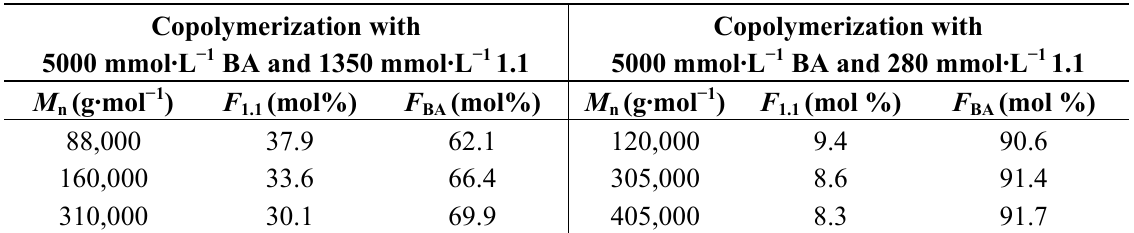
Table 3. Comparison of the molecular percentage of monomer units in the copolymers. Copolymerization with